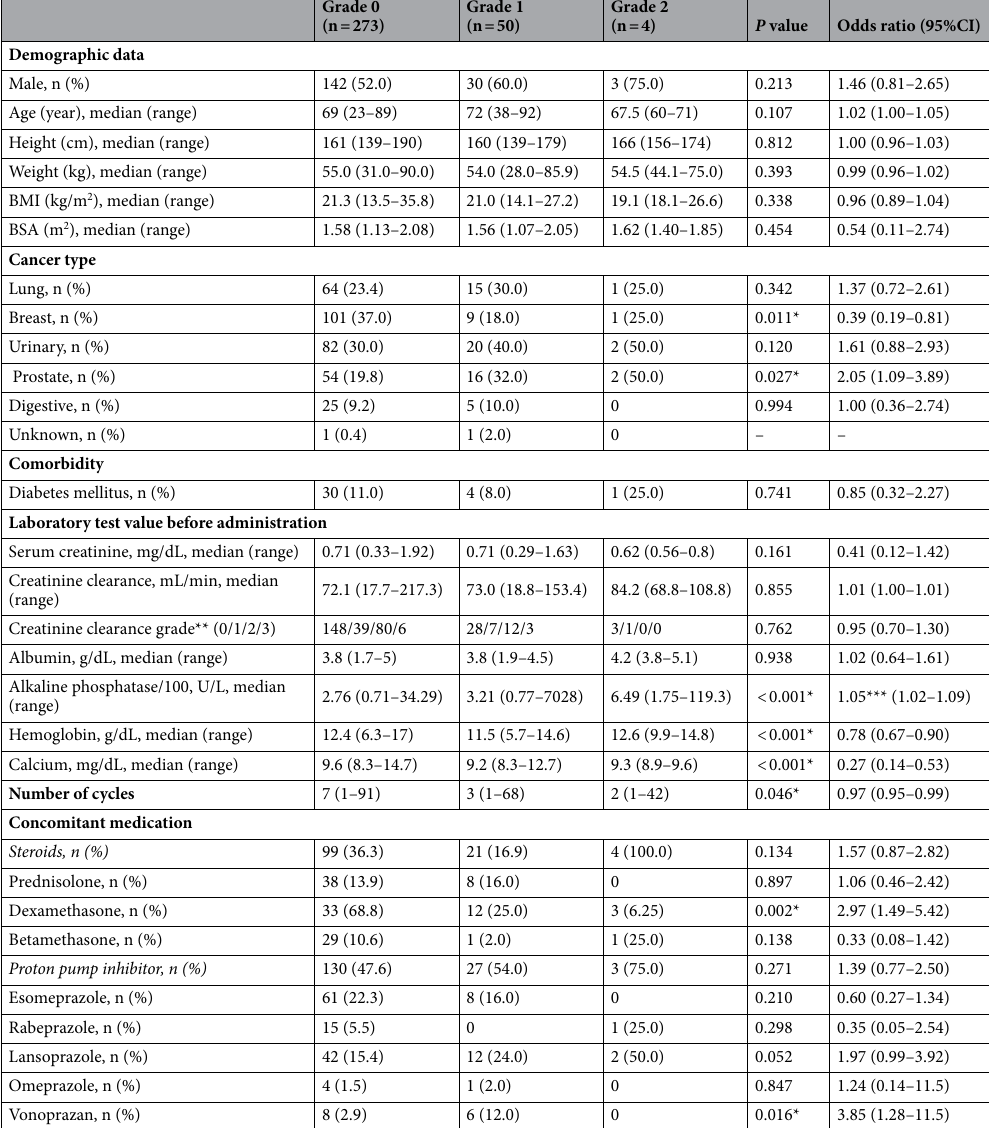
Table 1. Patient characteristics, extracted variables, and results of univariate analyses (n = 327). CI, confidence interval; BMI, body mass index; BSA, body surface area. *P < 0.05. **Evaluated by National Cancer